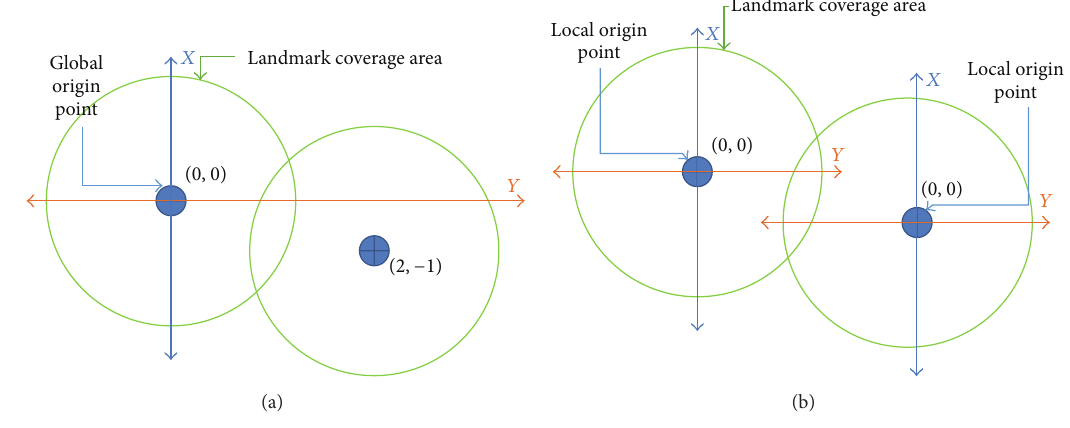
Figure 2: Data flow between MFS, RRC, and RMC.